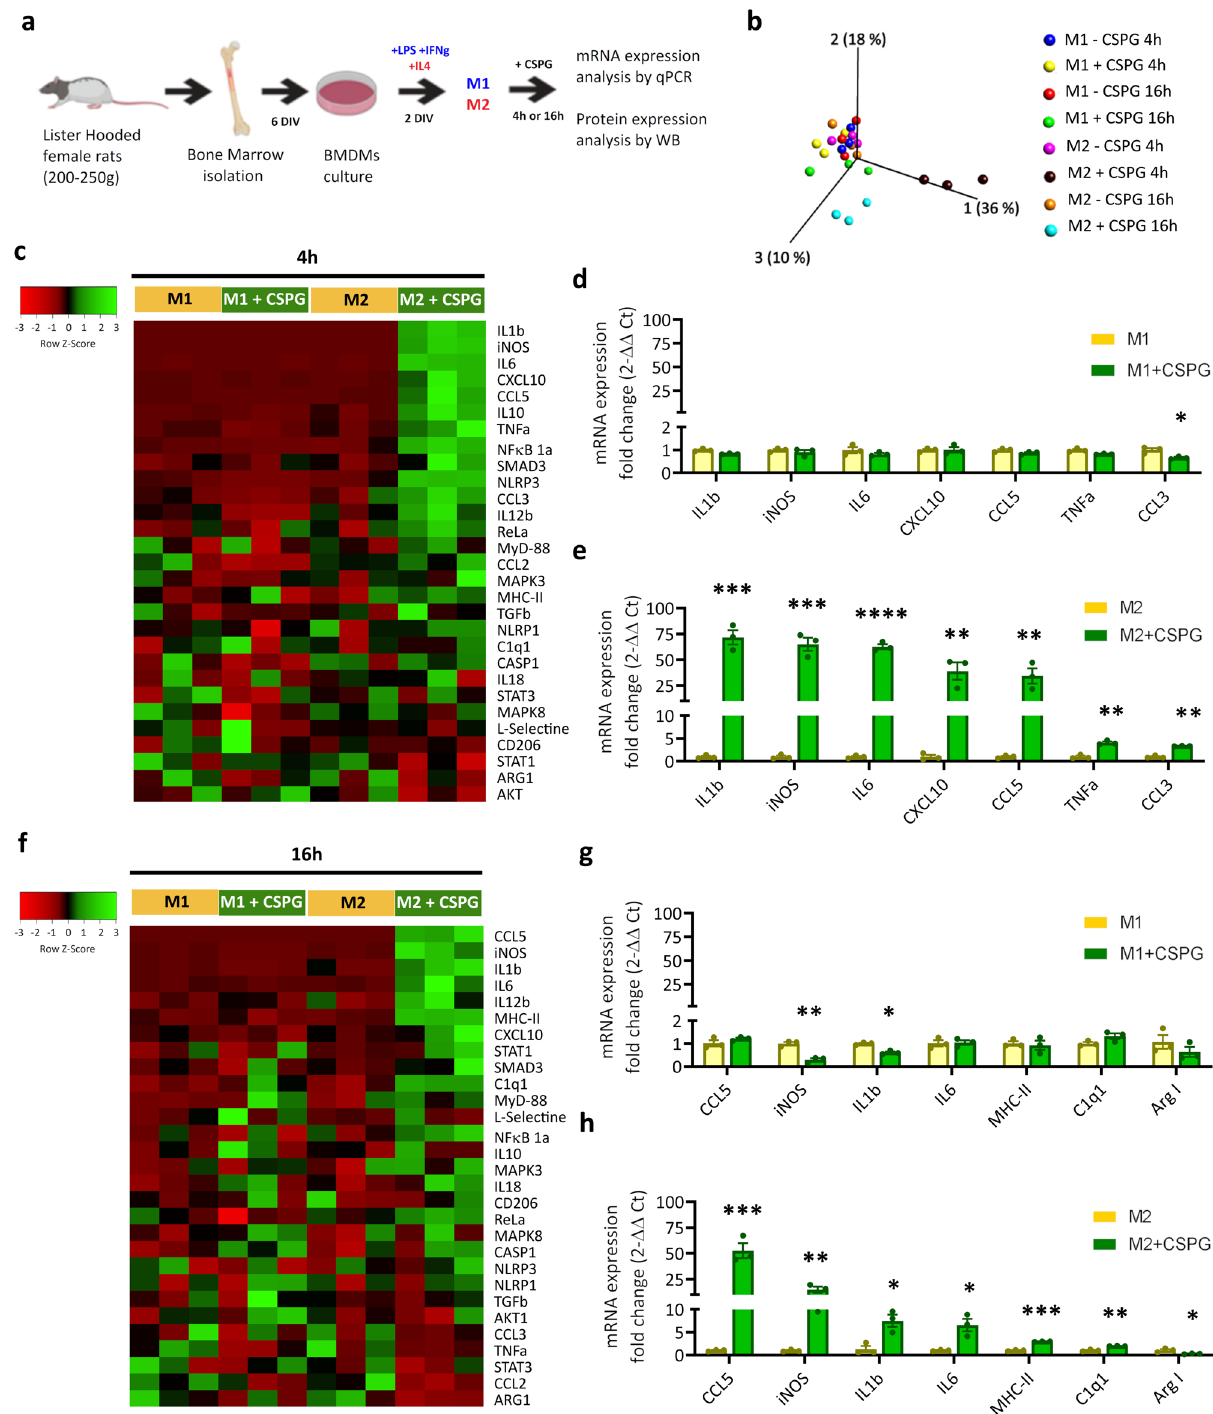
role for the digestion product itself in promoting an M2-like phenotype. Both macrophage and microglial responsiveness to CSPG digestion was next corroborated in vivo in FACS sorted microglial and macrophage cells from contusion injured spinal cords at 7 dpi (Fig. 7g; phenotype characteristics of sorted cells con fi rmed in Fig. 3j). Both macrophages and microglial cells exhibited reduced expression of in fl ammatory cytokine genes (Il1 β , CCL5 and CXCL0) after CSPG digestion at 7 dpi, with the effect more pronounced in macrophages (Fig. 7h).